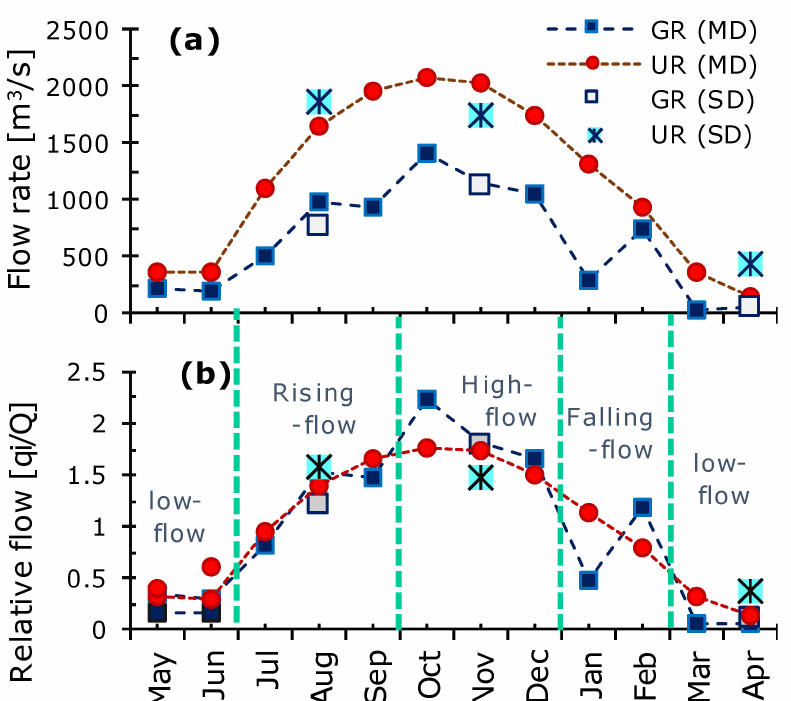
Figure 3. Intra-annual variability in flow at Los Í dolos (Grijalva) and Chichicastle (Usumacinta): ( a ) Flow rate (ADCP data); ( b ) Relative flow: Mean monthly flow (q i )/Mean annual flow (Q). GR: Grijalva River; UR: Usumacinta River; MD: Monthly data (from May 2016 to June 2017); SD: Seasonal data (November 2021, April 2022, and August 2022). Green lines indicate rain season.